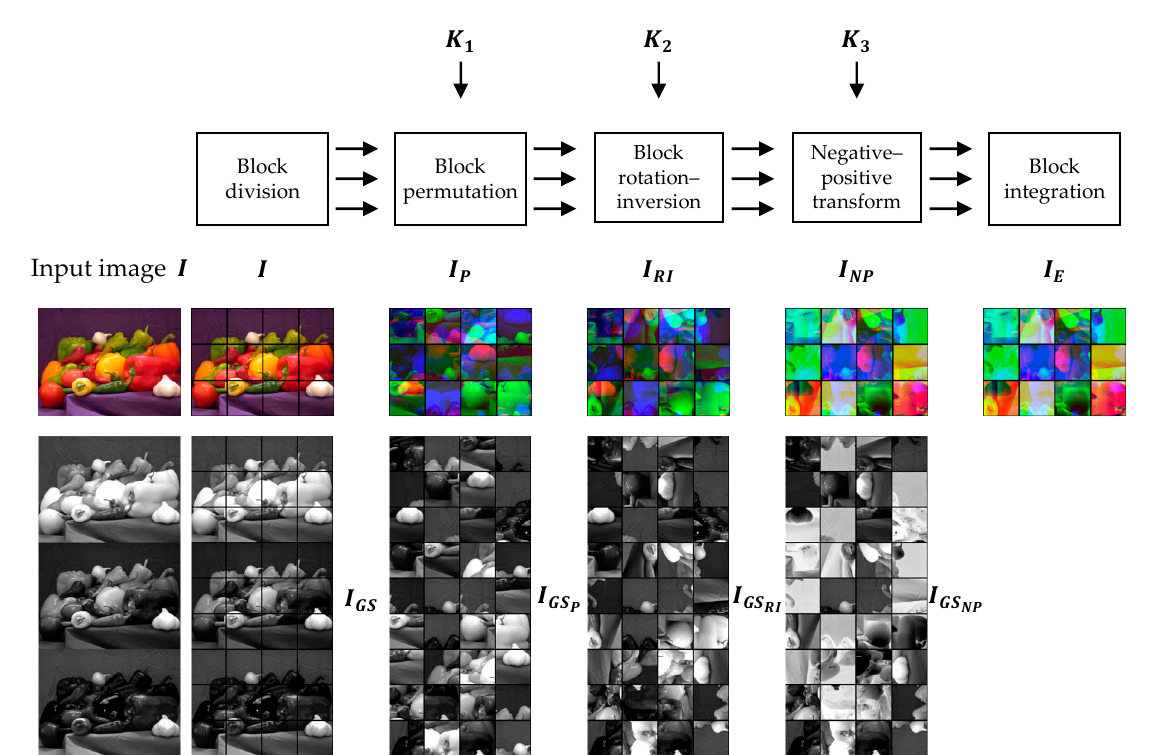
Figure 7. The encryption algorithm steps of a PGS–CPE scheme. The pseudo-grayscale representation was obtained by concatenating the RGB components along the vertical axis. For visual analysis, the effect of each transformation function on the image is shown. The keys K i , i = 1, . . . , 3 is used in each step to transform the blocks. The appearances of the blocks are similar to those from the methods that process the color component independently.